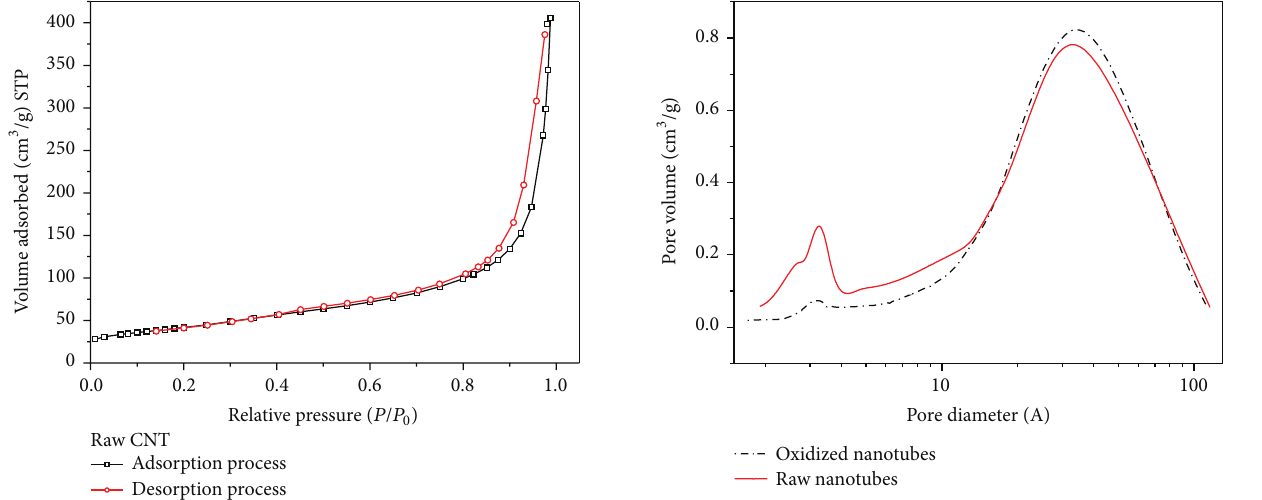
Figure 12: Adsorption-desorption isotherm of raw nanotubes.